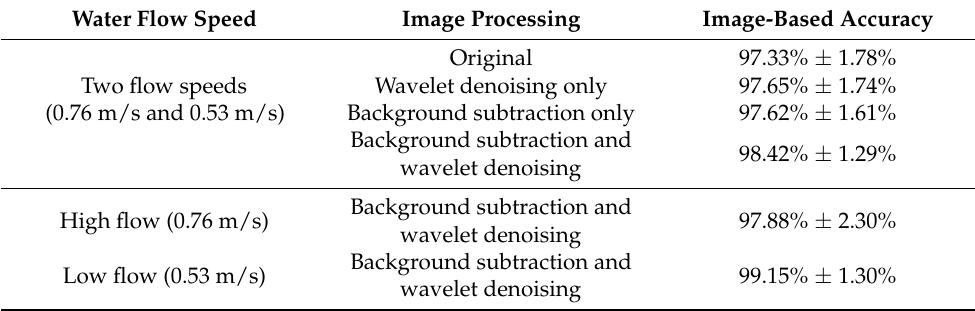
Table 3. Image-based overall accuracies of CNN classification of the laboratory sonar